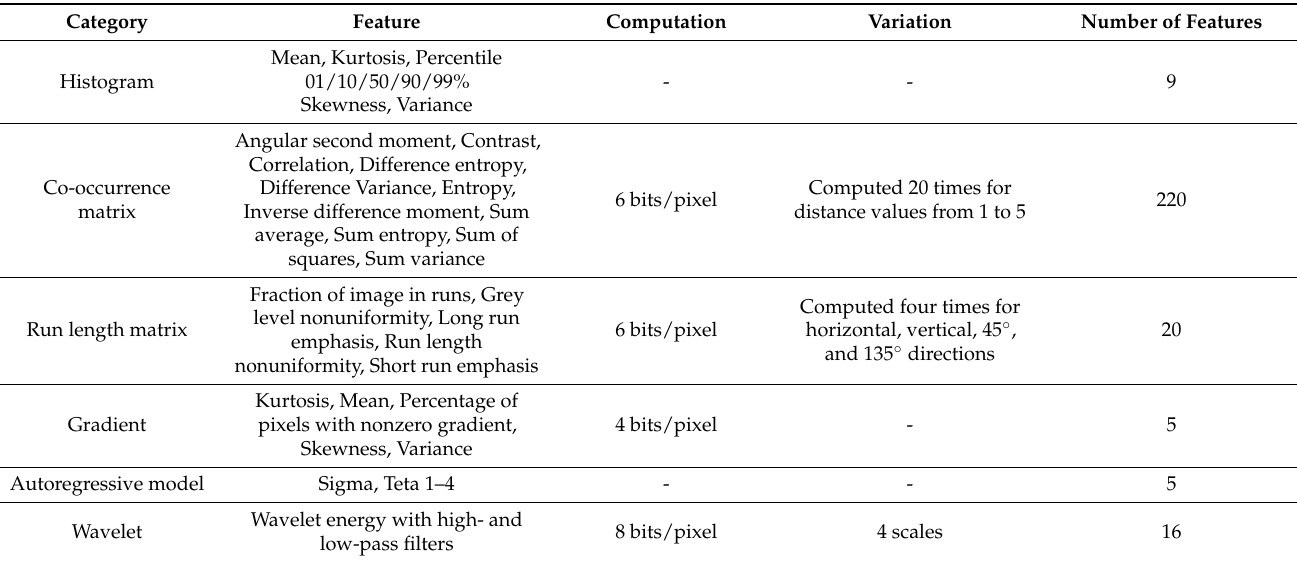
Table 1. The extracted radiomics features and the computation settings of each category.